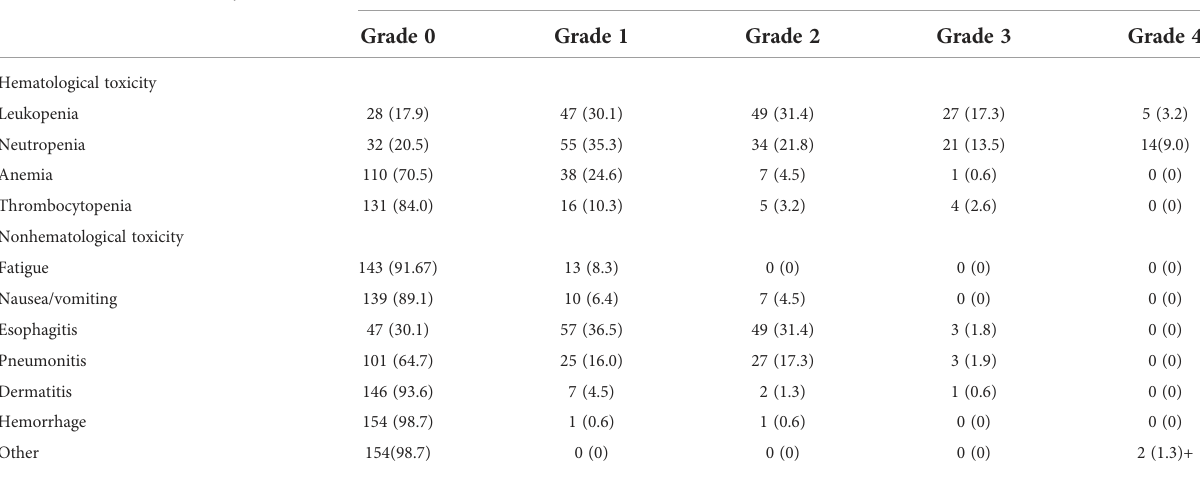
TABLE 3 Acute Treatment